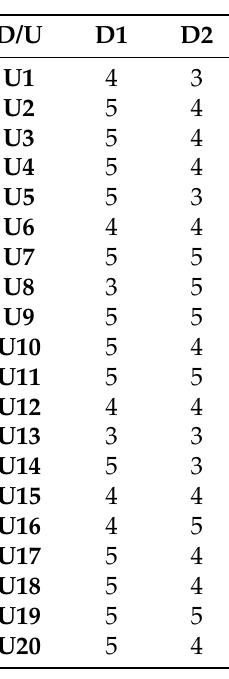
Table 3. Users responses to survey